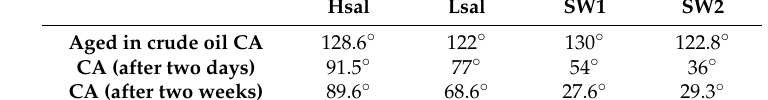
Table 6. CA values of samples of Case 4 (oil wet) in contact with brines for two days and two weeks. Hsal